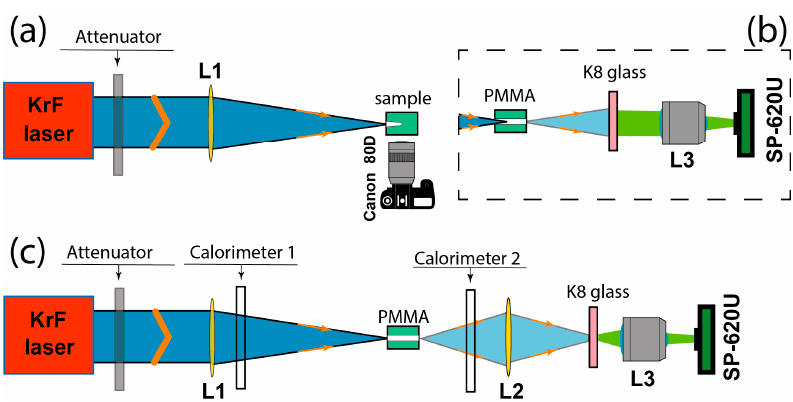
Figure 1. The layout of experiments on ( a ) multi-pulse sample drilling; ( b ) measurement of radiation distribution behind the drilled channel; ( c ) measurements of transmitted energy and distribution at the channel outlet.